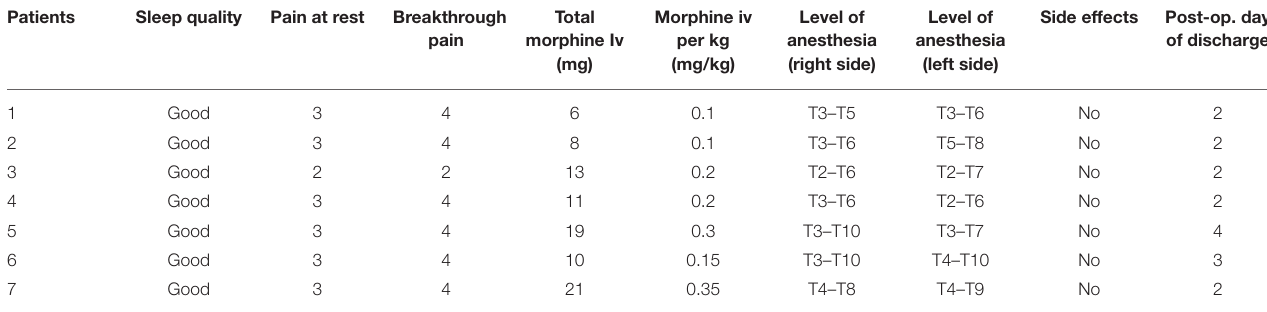
TABLE 3 | Post-operative data.